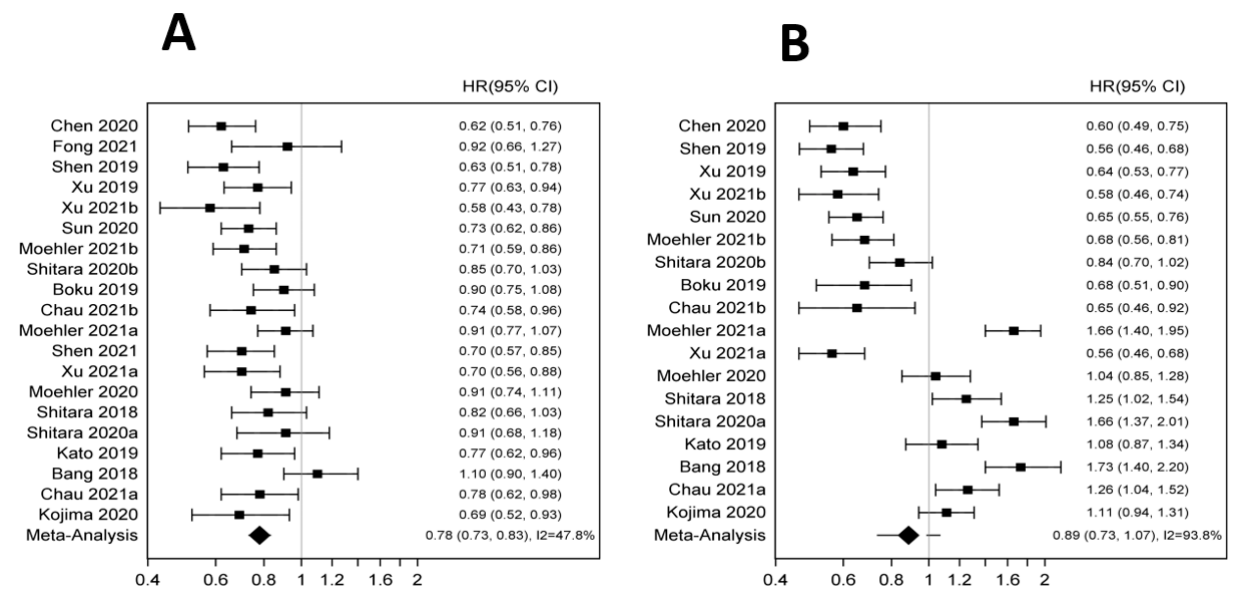
Figure 2. ( A ): Forest plot for overall survival in the total population. ( B ): Forest plot for progression free survival in the total population [5,6,13–27].